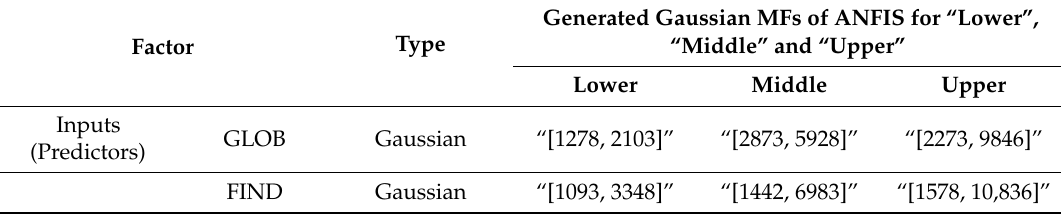
Table 4. Generated Gaussian MFs of the ANFIS